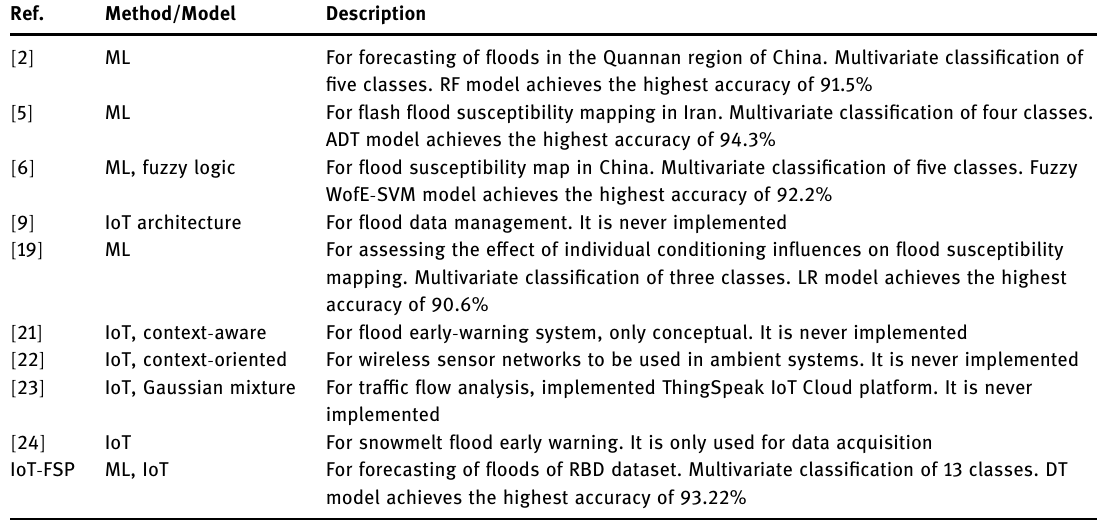
Table 3: Comparison with the related work